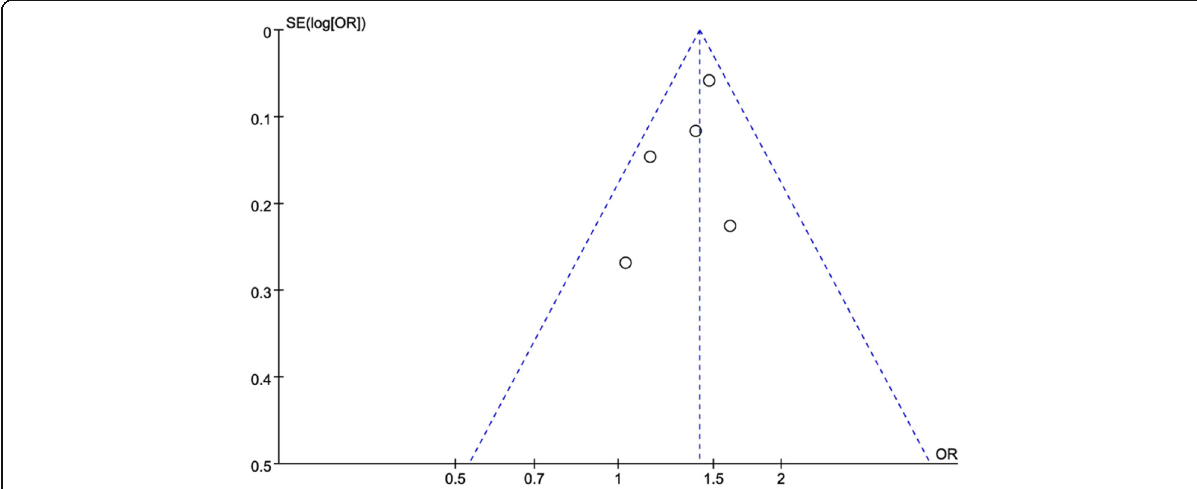
Fig. 4 Funnel plot of publication bias in selection of studies on the FTO rs9939609 A/T polymorphism. Publication bias was assessed under dominant model (AA + AT vs. TT). SE represents standard error; OR represents odds